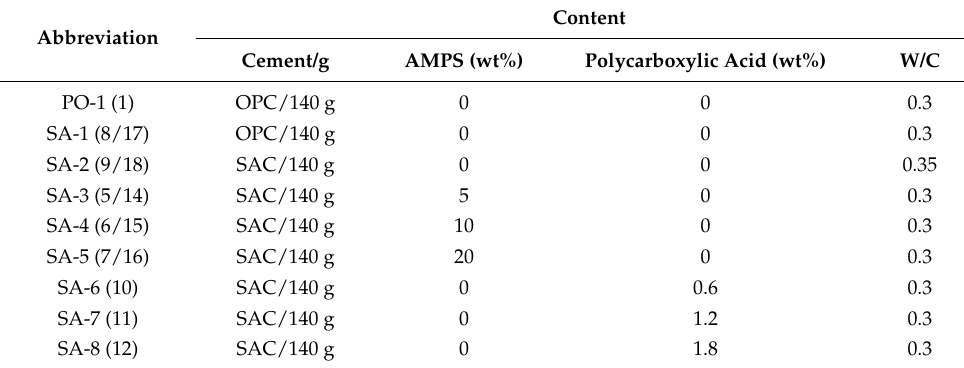
Table 2. List of cement paste